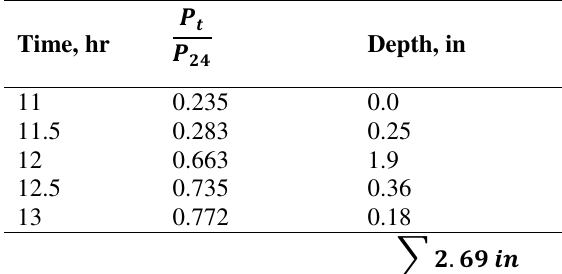
Rainfall depth calculations using NRCS